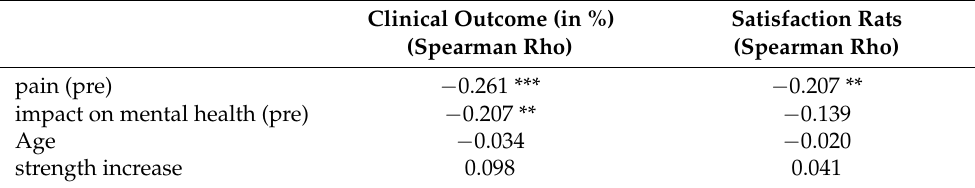
Table 2. Comparison of outcome measures (mean ± standard deviation) in patients with different affected disc levels and different durations of symptoms.